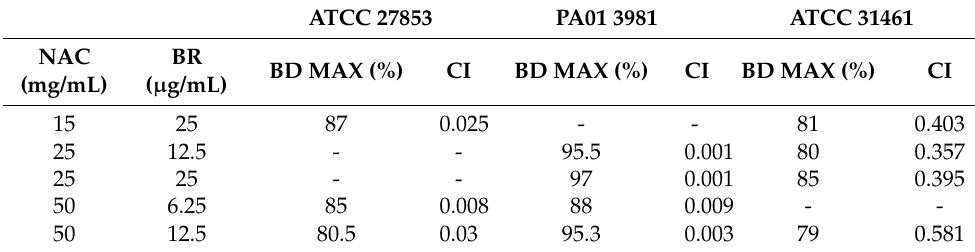
Table 4. Comparison of maximum biofilm dissolution (BD MAX 80% and above) using a combination of agents in the three strains of Pseudomonas aeruginosa. The sensitivity to N -acetylcysteine with 50 mg/mL + bromelain 12.5 µ g/mL indicates that strain PA01 3981 was the most sensitive, whilst the other two strains were almost equally sensitive. CI = combination